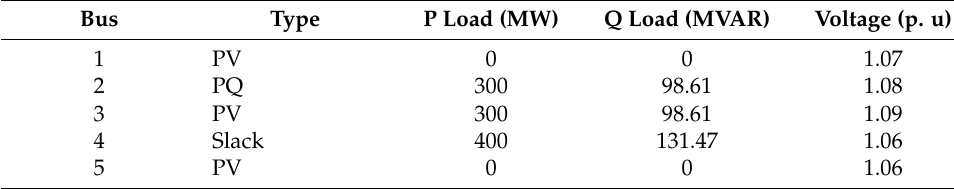
Table 2. Bus data.